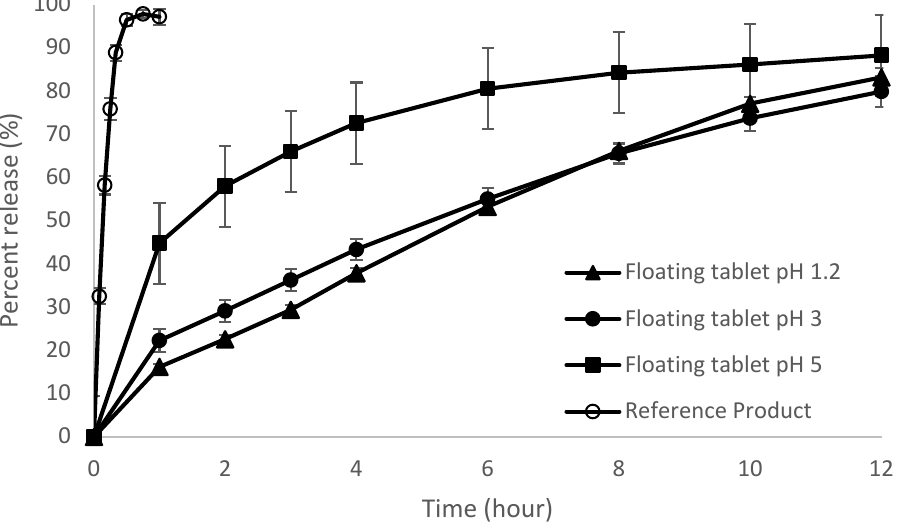
Figure 1. Dissolution profiles of the reference product in pH 1.2 and floating tablets in pH 1.2, 3, and 5 ( n = 6, mean ± SD).